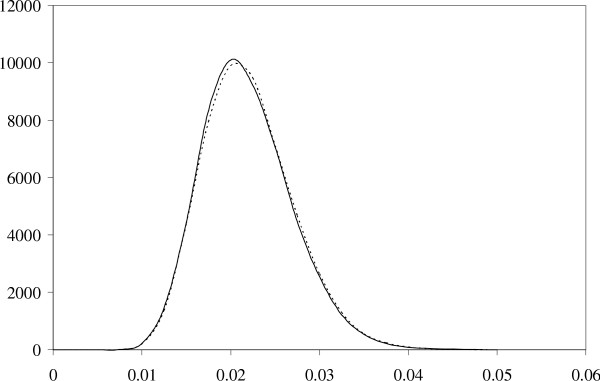
Posterior distribution of deletion rate μ. Estimated posterior densities of the deletion rate μ sampled according to h (see text), for two independent runs, suggesting excellent convergence. The sampled mean is 0.0207; the 95% highest posterior density (HPD) interval was estimated to be (0.0121, 0.0316).